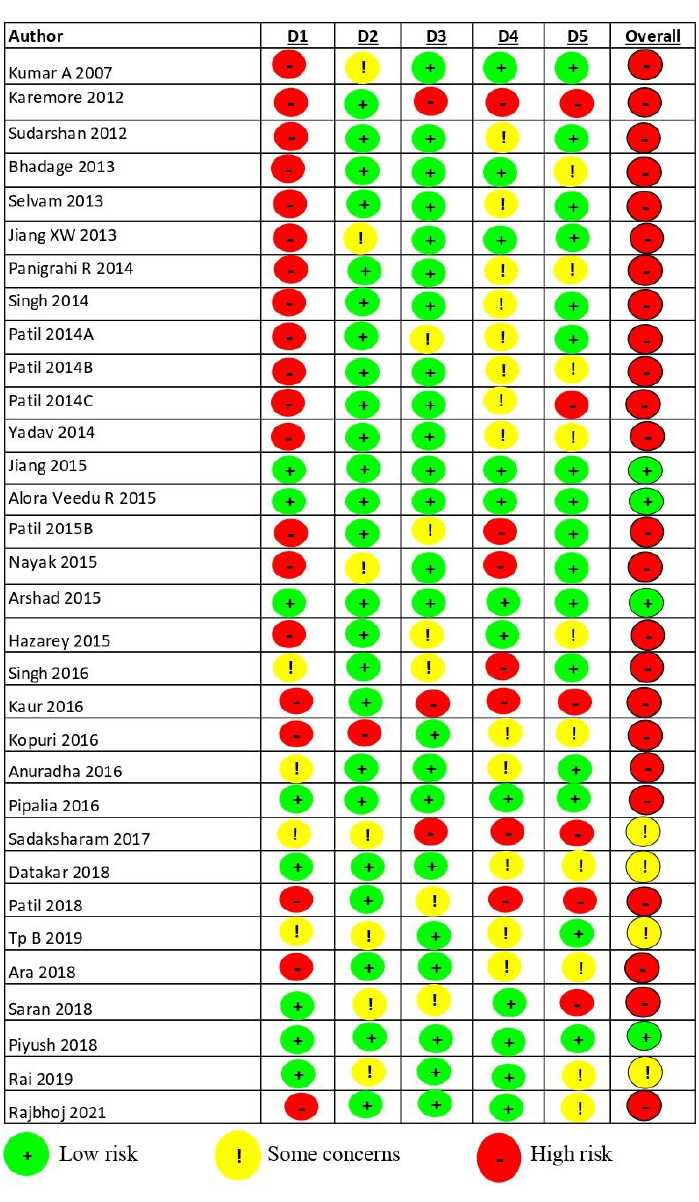
Figure 8. Summary of risk of bias.